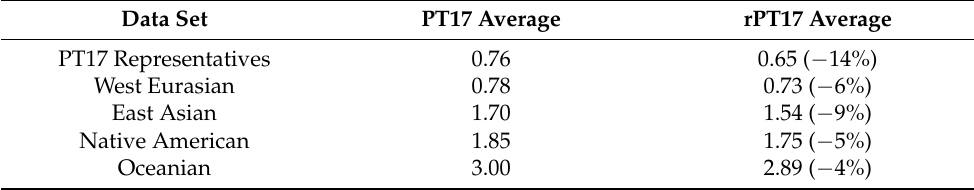
Table 2. Average number of essential private mutations for CR sequences.